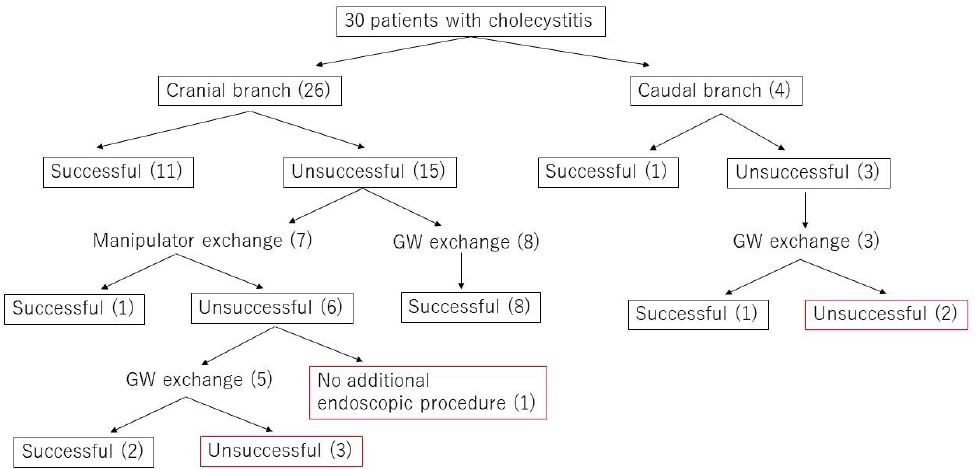
Figure 5. The cholecystitis cases were divided into two groups according to the direction of the cystic duct.